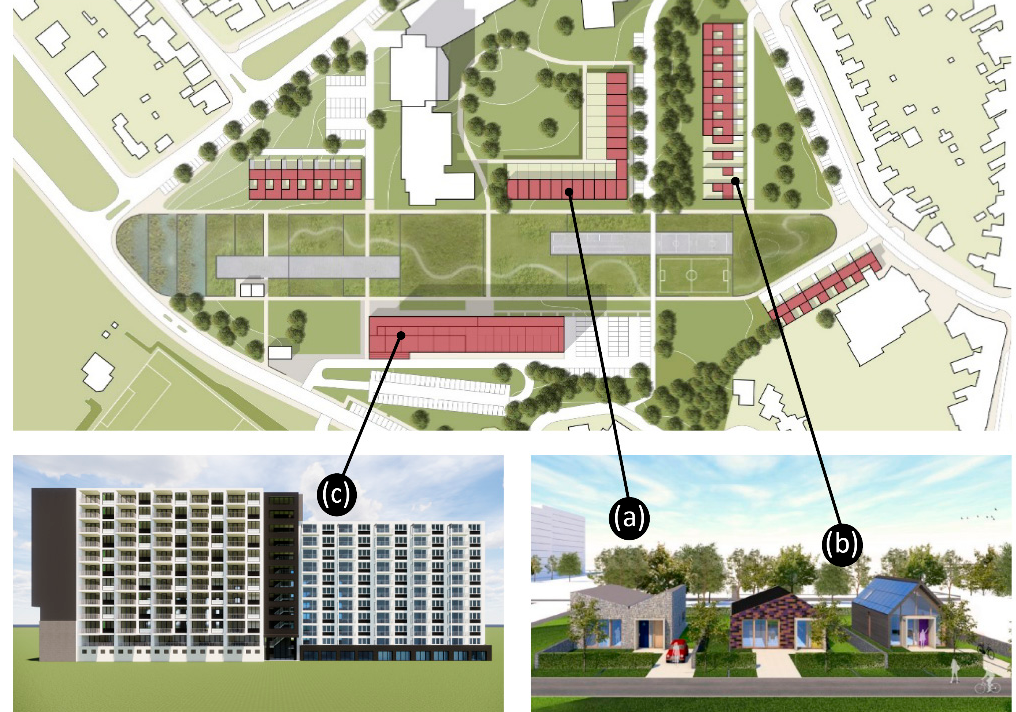
Figure 2. Overview of the case study and household types of SUPERLOCAL. Table 2. The case study and household types of SUPERLOCAL.